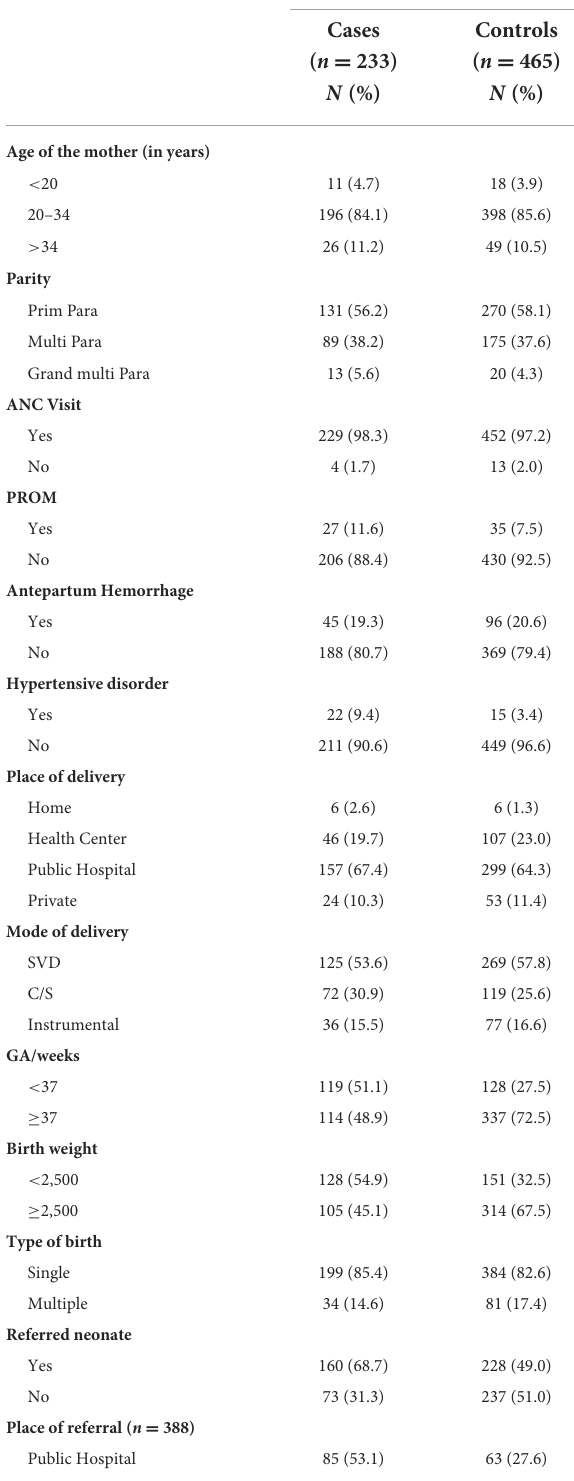
TABLE 1 Maternal and neonatal related factors for neonates admitted to neonatal intensive care unit of Dessie comprehensive and specialized hospital, Northeast Ethiopia, 2020 ( n =